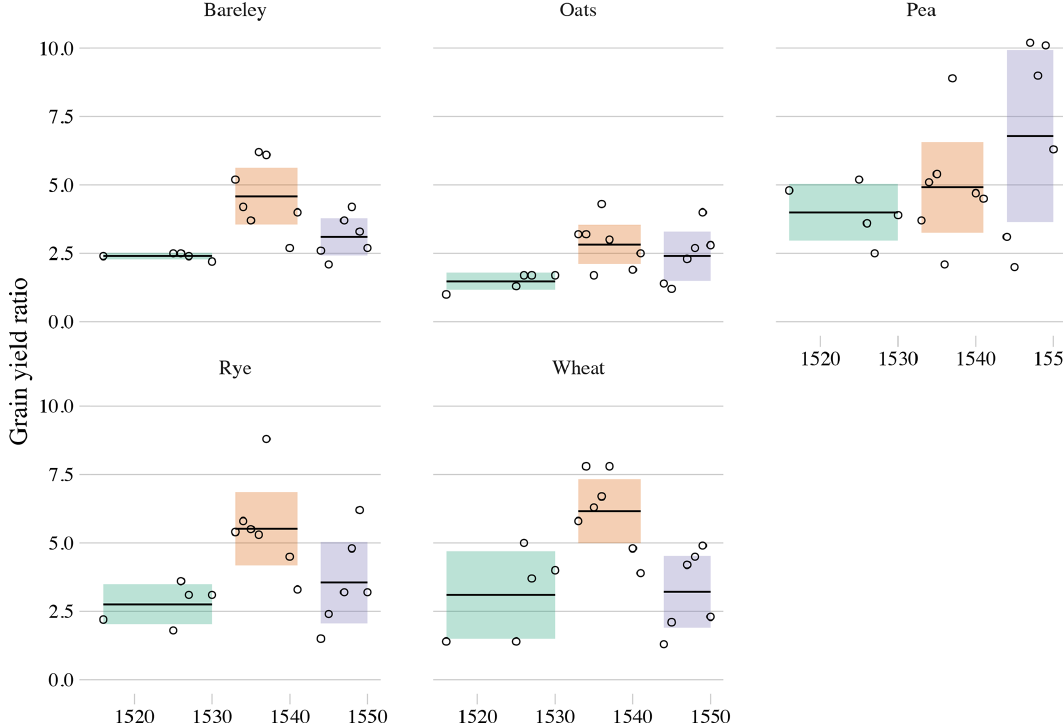
Figure 4. Grain yield ratio of main crops in Malbork Royal Economy. Sources: Szpak